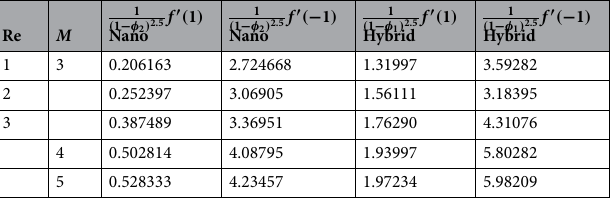
Table 4. Skin friction at lower and upper cases versus different values of physical constraints.